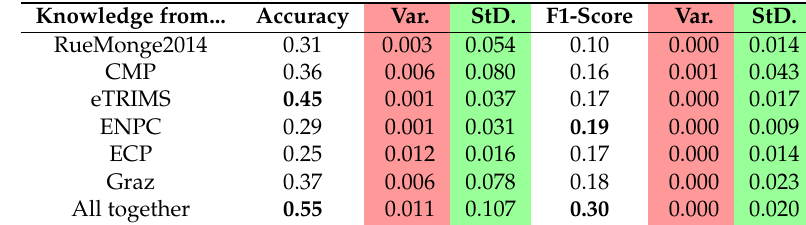
Table 5. Inference accuracy over the SJC data. The last row corresponds to the accuracy with the knowledge of all trainings together. The values in bold, expose the best datasets according to the Accuracy and F1-Score metrics. When together, the quality metrics increased due to the better generalization of the neural network, as it has received a bigger amount of images. Knowledge